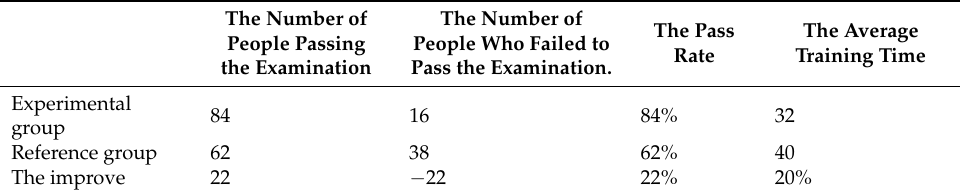
Table 3. Improvement of AI-DTS in practical